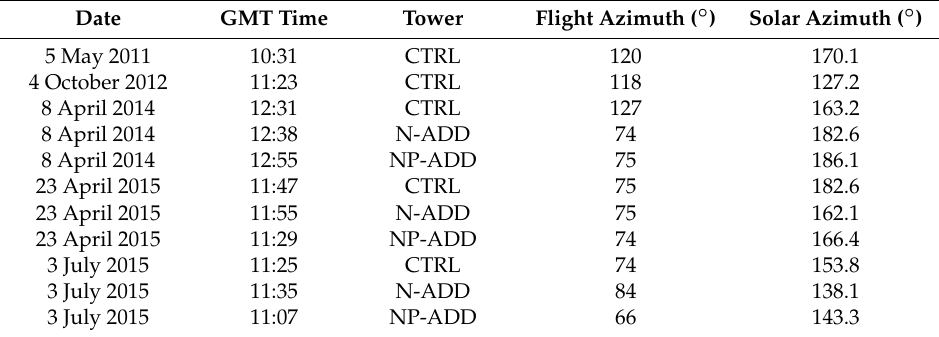
Table 1. Characteristics of the eleven overpasses of the Compact Airborne Spectrographic Imager (CASI) imagery acquired in the Majadas del Ti é tar research